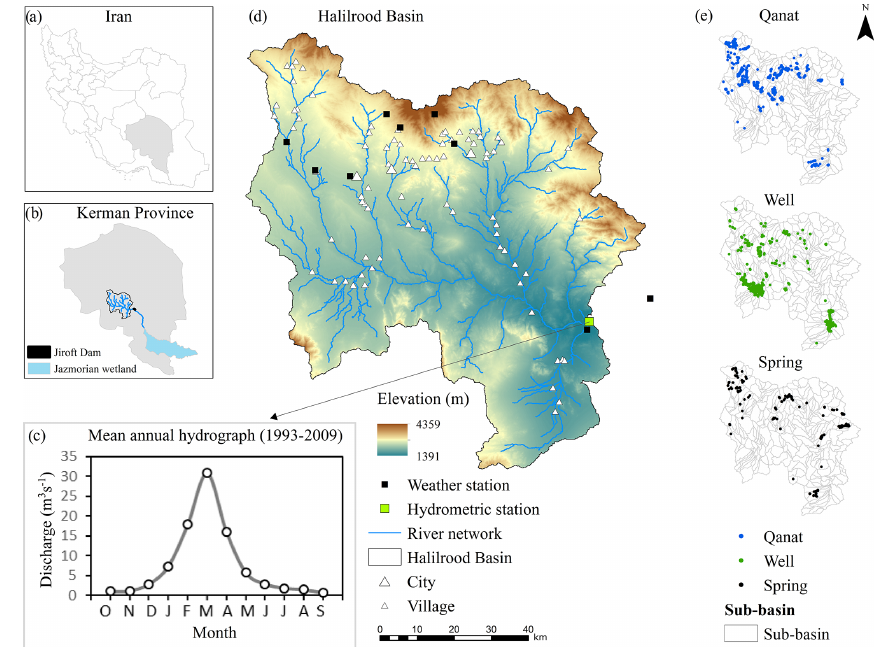
Figure 1. Location of the Halilrood Basin, water use systems, and monitoring stations considered in this study. Average monthly streamflows derived from the observed data at the outlet of the